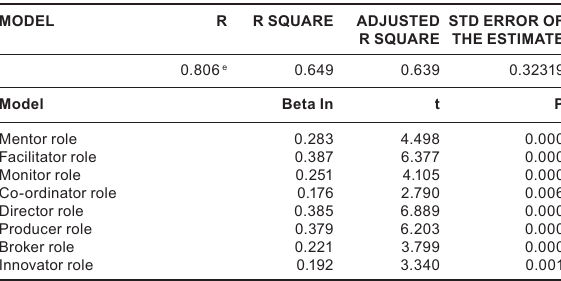
Table 7 Multiple Regression: Managerial roles contributing to accomplishing TQM